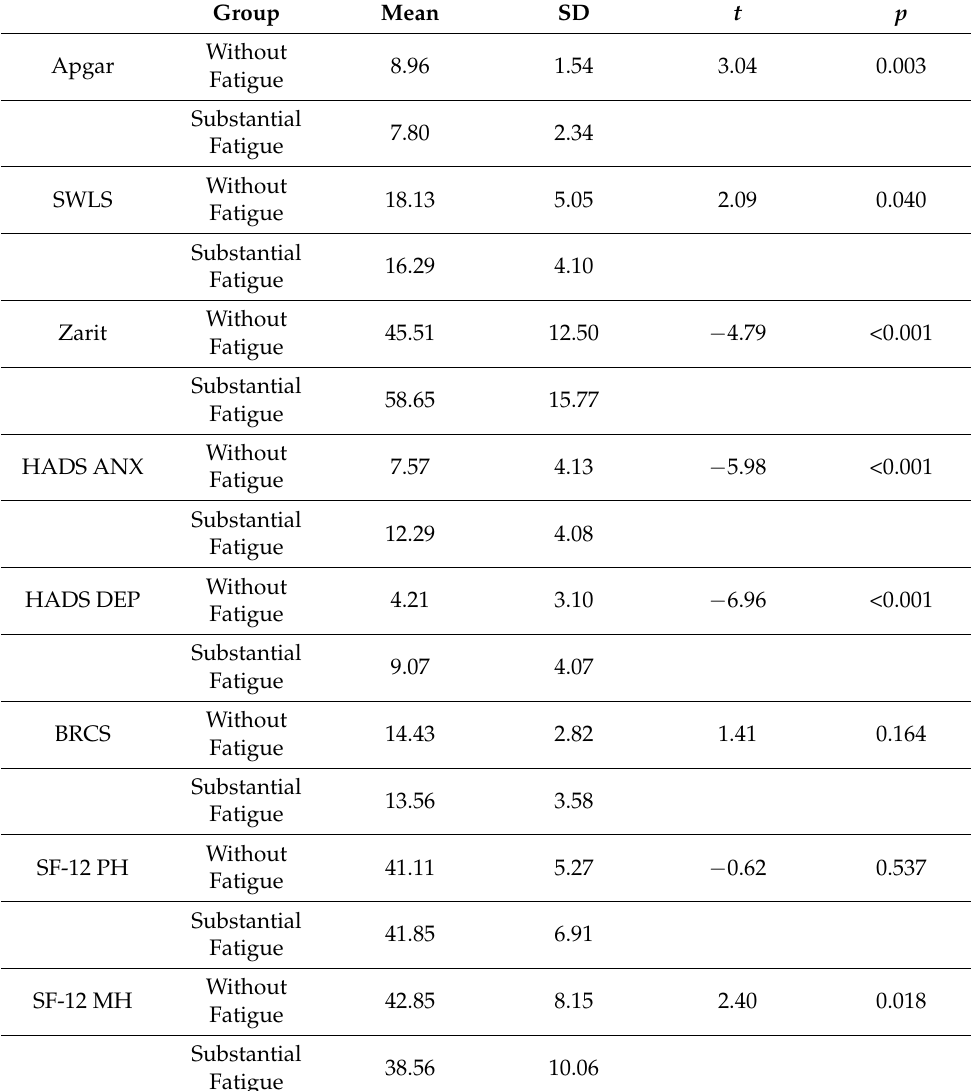
Table 4. Differences between groups with substantial fatigue and without fatigue in family function- ing, life satisfaction, caregiver burden, anxiety, depression and health-related quality of life.